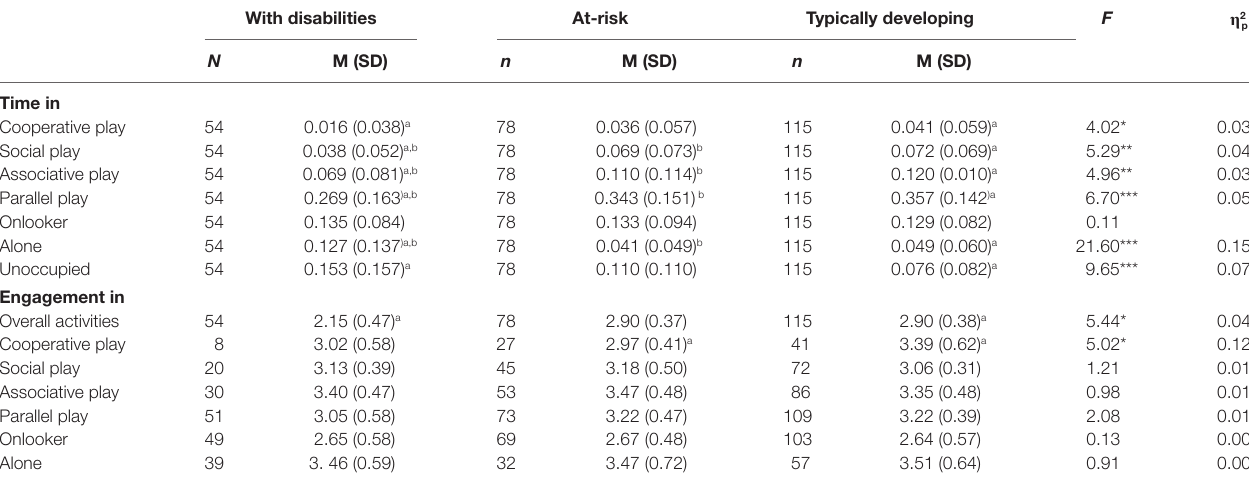
tablE 2 | Mean differences between the proportion of time spent and engagement levels in activities with different levels of social complexity, between the three groups of children: with disabilities, at-risk, and typically developing. With disabilities